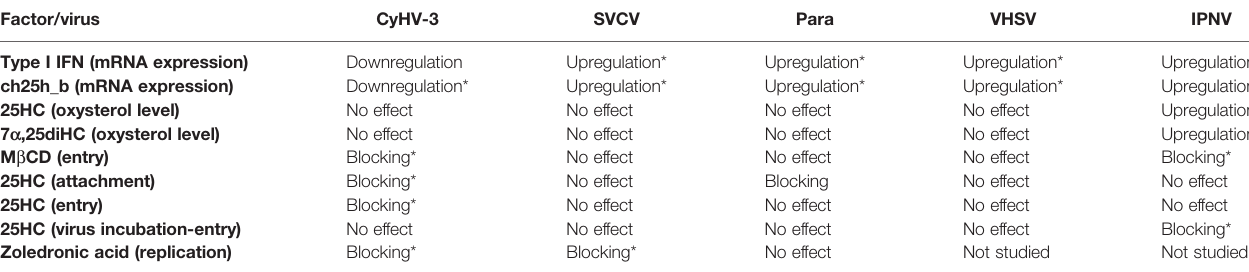
TABLE 2 | Summary of the results presenting the in fl uence of selected viruses on mRNA expression levels of cholesterol 25-hydroxylase and the in fl uence of methyl- b - cyclodextrin (M b CD), 25-hydroxycholesterol (25HC), and zoledronic acid on entry/replication of CyHV-3, SVCV, Para, VHSV, and IPNV Factor/virus